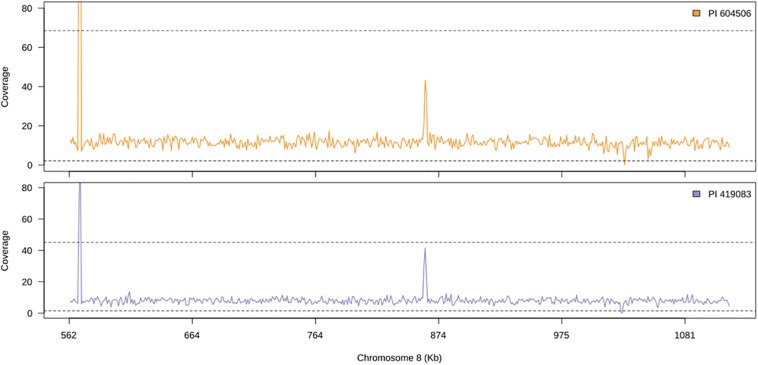
Genomic coverage along candidate region of chromosome 8 of the two accession used as parents for quantitative trait locus (QTL) mapping. Solid line shows the average coverage for 1-kb windows. Dashed line shows the upper and lower 99% confidence interval for the observed coverage for the whole genome.